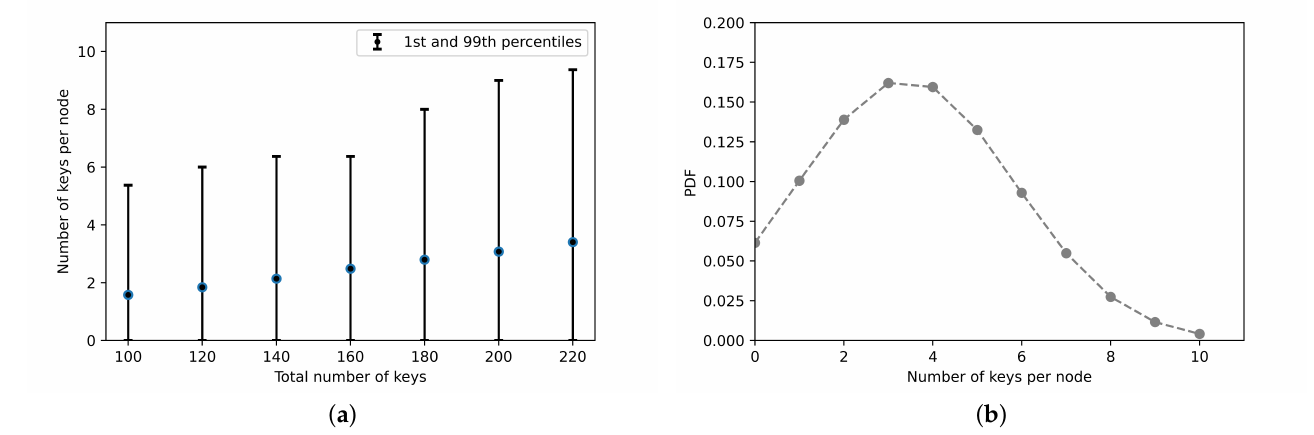
Figure 8. ( a ) The 1st and 99th percentiles and mean values of number of stored keys by a node in a network with 64 nodes. ( b ) The probability density function ( PDF ) of number of keys per node. The total keys is 220.